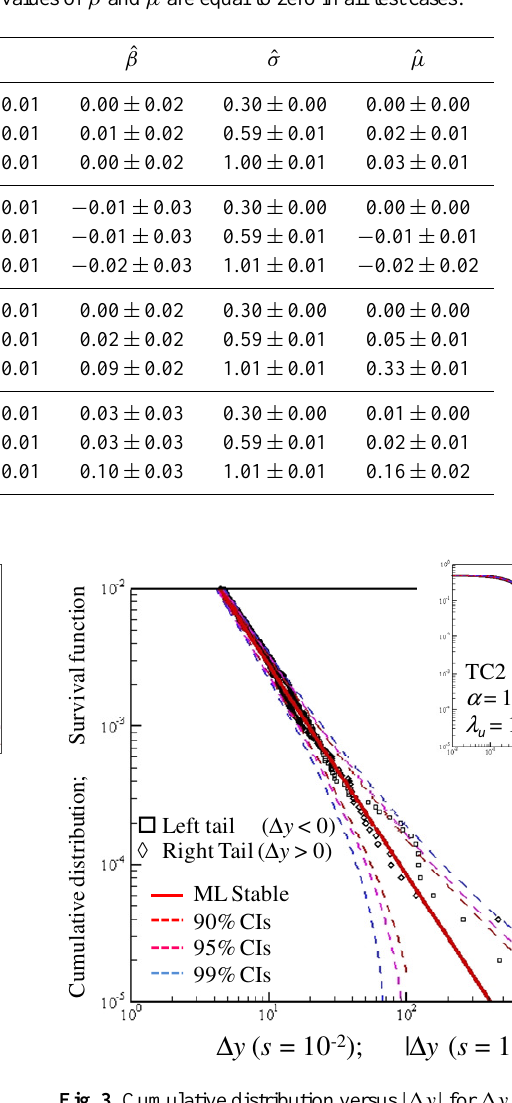
Fig. 2. Cumulative distribution versus | 1y | for 1y < 0 and survival function versus 1y for 1y > 0 of TC1 at s = 10 − 2 . Main figure emphasizes behaviour at tails. Solid curves represent ML fitted sta- ble distribution; dashed curves indicate confidence intervals, CIs.